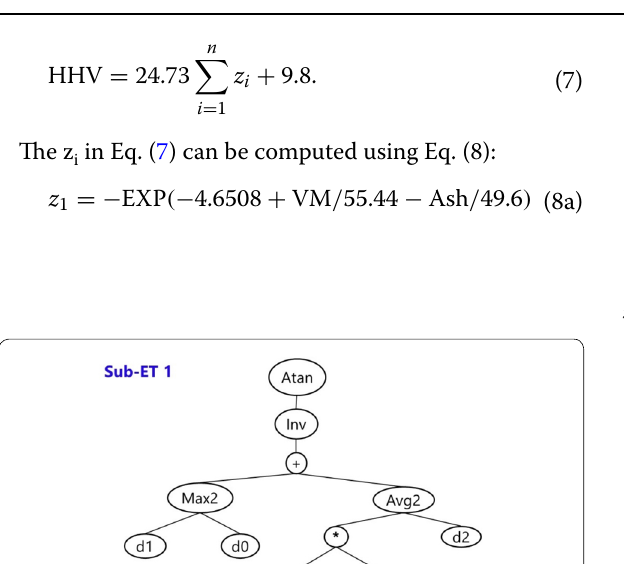
Artificial neural network A MISO-ANN is proposed in this study for the predic- tion of EY, MY, and HHV. To achieve this, single hidden- layer and double hidden-layers were tried for each of the EY, MY, and HHV as presented in Tables 3, 4. The optimum networks obtained for each of the EY, MY, and HHV are presented in Figs. 7 and 8. In developing the MISO-ANN models, the number of neurons in the input, hidden, and output layers are to be defined and the respective transfer functions at the hidden and out- put layers are to be defined. Therefore, in this study, there are five neurons in the input layers comprising VM, Ash, FC, Temp, and RT. For the hidden layer, several neurons ranging from 3 to 15 were tried for the MISO-ANN with single hidden layer architecture, while for the MISO- ANN with double hidden layer architecture, the neurons combinations tried ranged 5–3 to 15–15 for each of the targeted variables. The transfer function adopted for the network with a single hidden layer is a hyperbolic tangent for the hidden and output layers, respectively. For the double hidden layer, hyperbolic tangent was used in the first and second hidden layers, while purlin was used for the output layer. Feedforward Backpropagation training algorithm with Levenberg–Marquardt training function was used for the training of the network. One hundred and fifteen (115) datasets were used for model develop- ment, divided into 70% for training, 15% each for testing, and validation, respectively (Fig. 2). The datasets